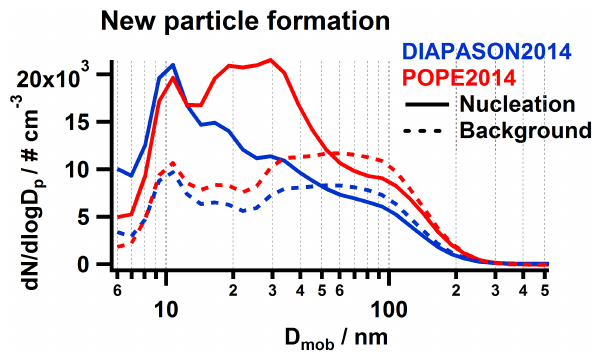
Figure 6. Average size distributions of particle number concen- trations (dN/dlog D p ) for maximum PNC at midday (DIAPA- SON2014: 13:00–15:00; POPE2014: 14:00–15:00; solid traces) and during background conditions (10:00–11:00; dashed traces) from FMPS measurements for DIAPASON2014 (blue) and POPE2014 (red). D mob is the mobility